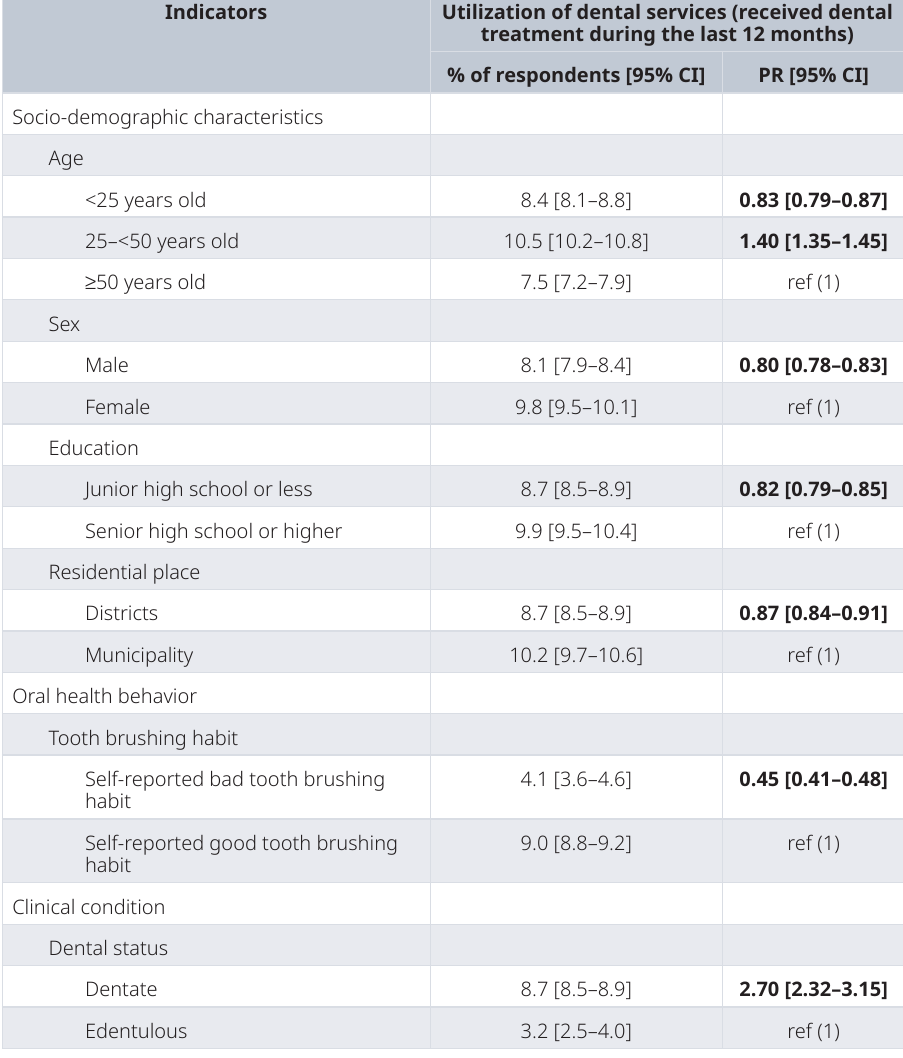
Table 2. Bivariate analysis of the association between dental service utilization and each of the explanatory variables.